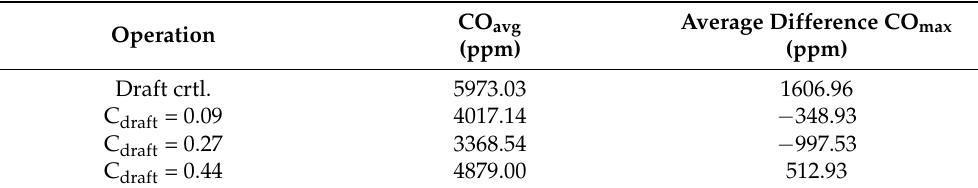
Table 4. Average CO